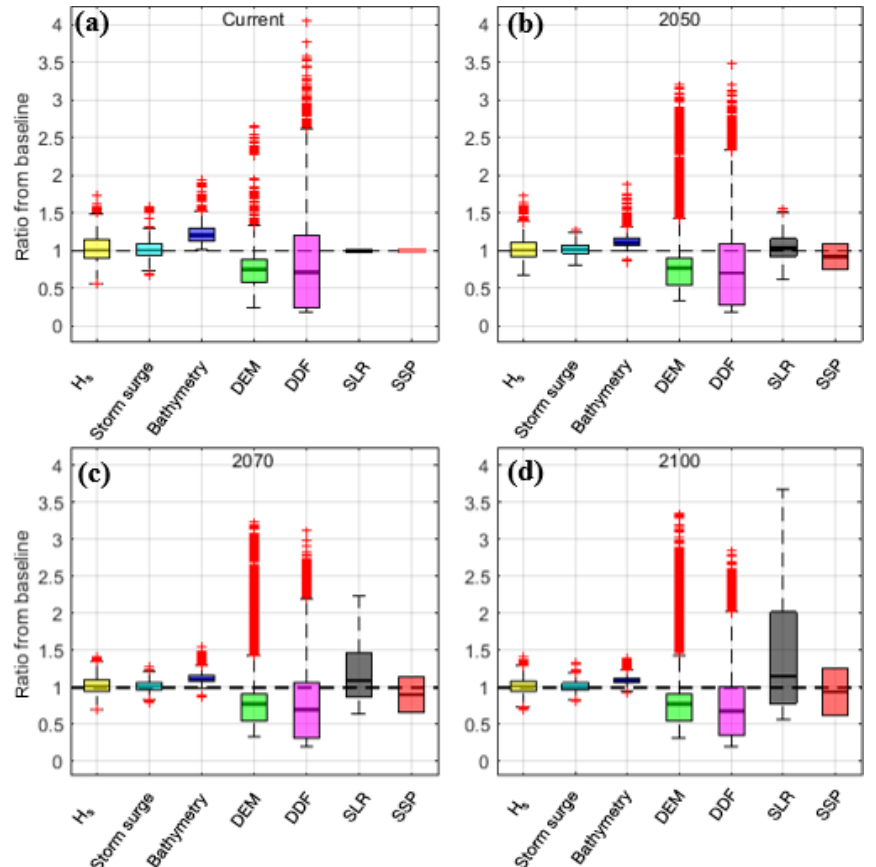
Figure 7. Absolute impacts on damage estimate uncertainty. Box plots of the ratio of damages from the baseline scenario for H s , storm surge, bathymetry, DEM, DDFs, SLR and SSP (a–d) , for the four time horizons (present day, 2050, 2070 and 2100). Mean values are represented by the black lines inside the boxes. The 25th and 75th percentiles are indicated by the edges of the boxes. The black thin whiskers extend to 1.5 times the interquartile distance, outside of which are outliers, shown with red crosses. The black dashed line shows the reference of the baseline